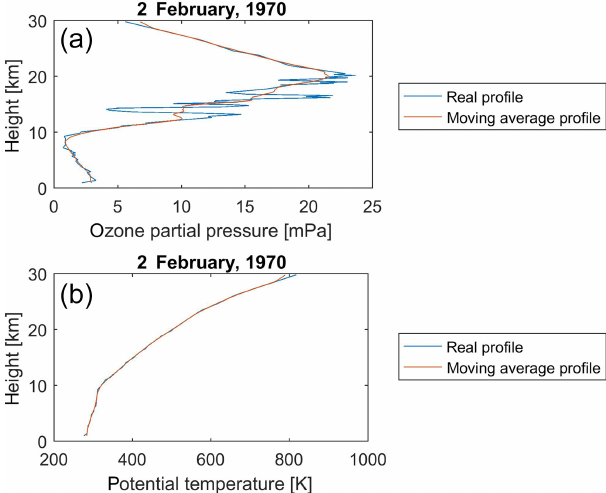
Figure 1. Real and smooth ozone (a) and potential temperature (b) vertical profile at Hohenpeissenberg from 2 February 1970.